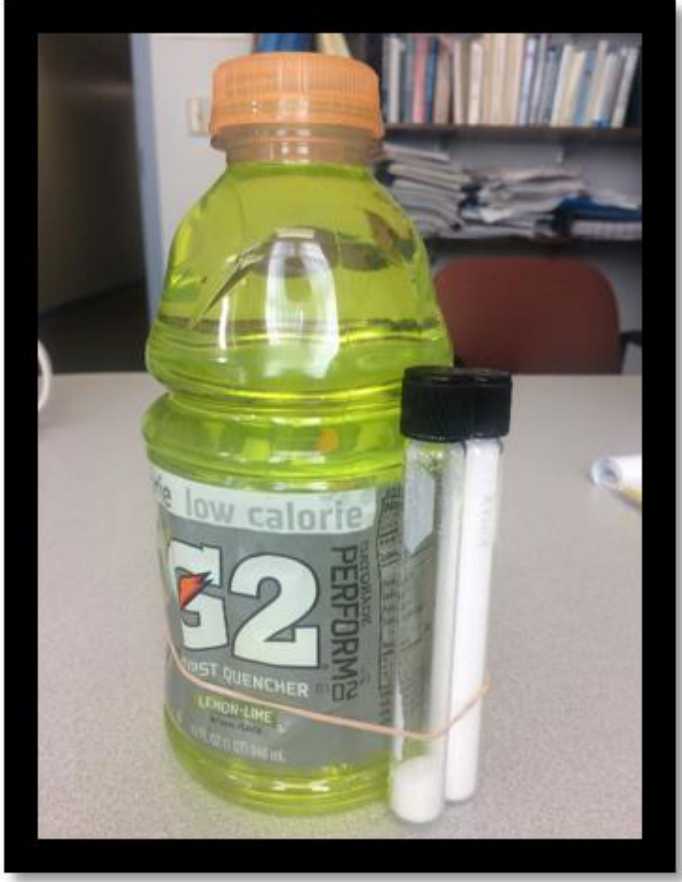
Figure 1. A drink with its sugar content displayed.